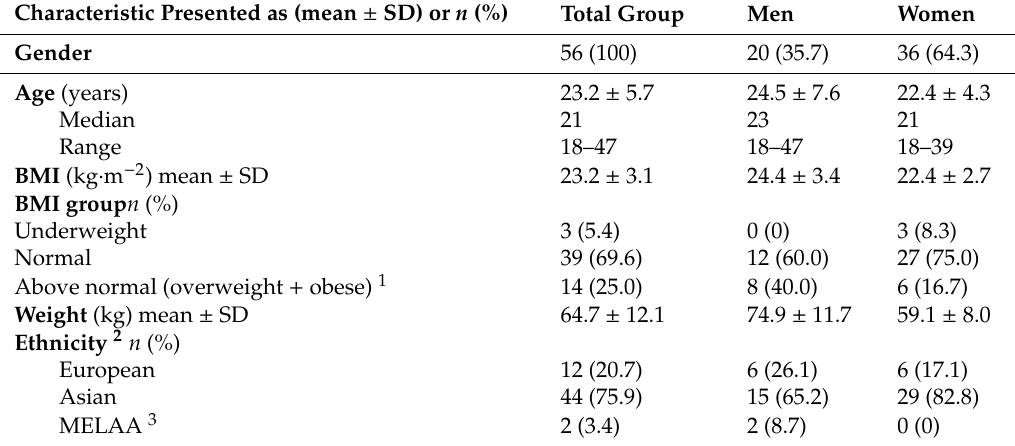
Table 1. Participant